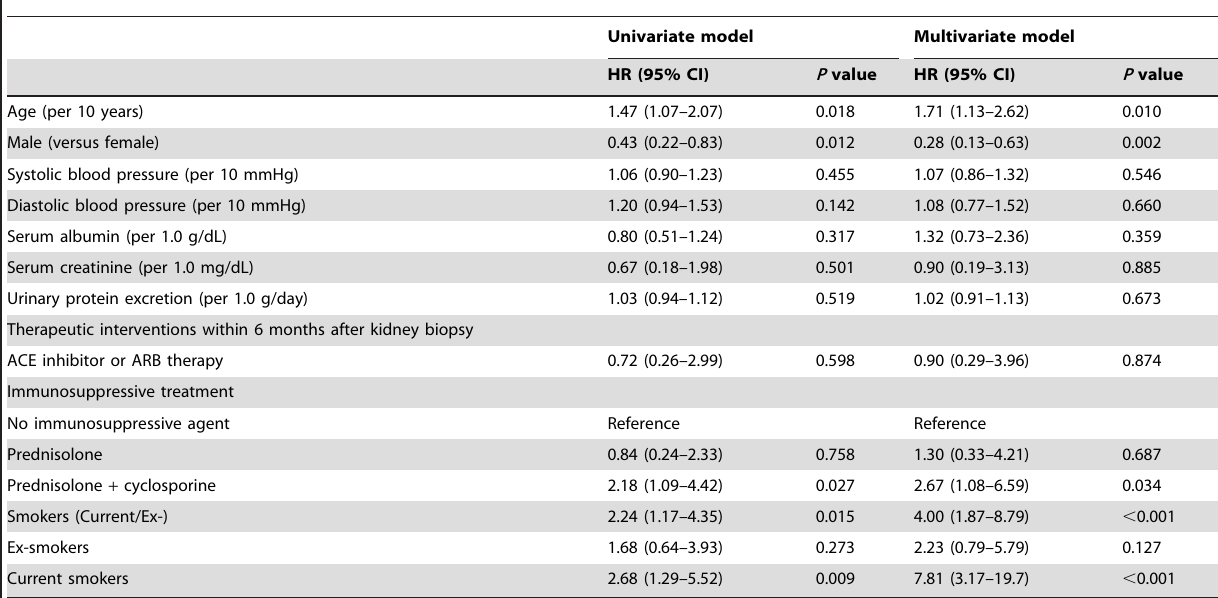
Table 2. Predictors of a 30% decline in